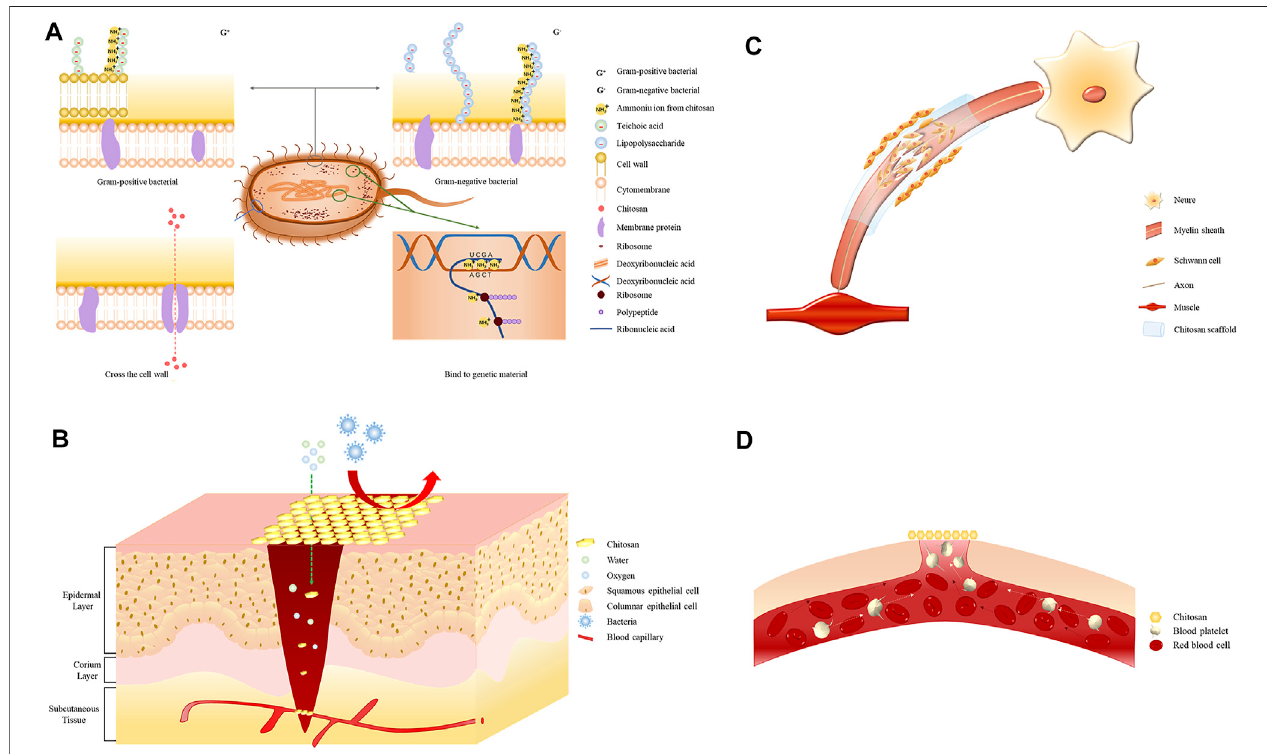
FIGURE 1 | (A) Electrostatic interaction of the positively charged ammonium ion with the negatively charged teichoic acid in Gram-positive bacteria. The positively charged ammonium ion interacts electrostatically with the negatively charged phospholipid molecule in Gram-negative bacteria. Chitosan molecules enter through protein channels on the bacterial membrane and interfere with physiological functions. Electrostatic interaction of the positively charged ammonium ion with the negativelychargednucleicacidgroup. (B)